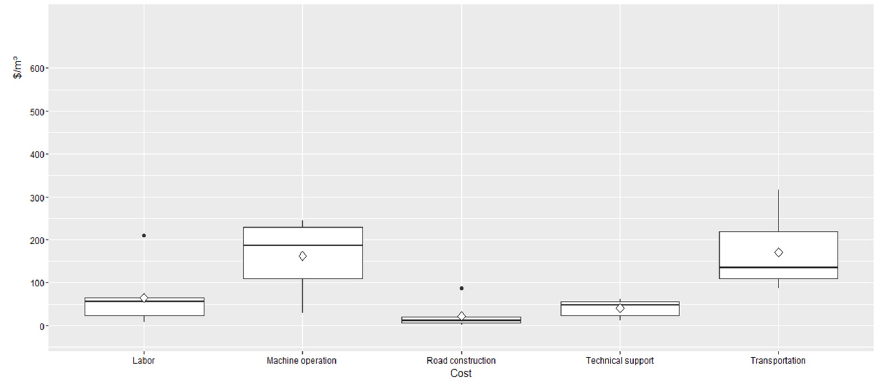
Figure 4. Boxplot of sampled variable cost for the northern region ( n = 7) summarizing distribution, mean, median, skewness and outliers.